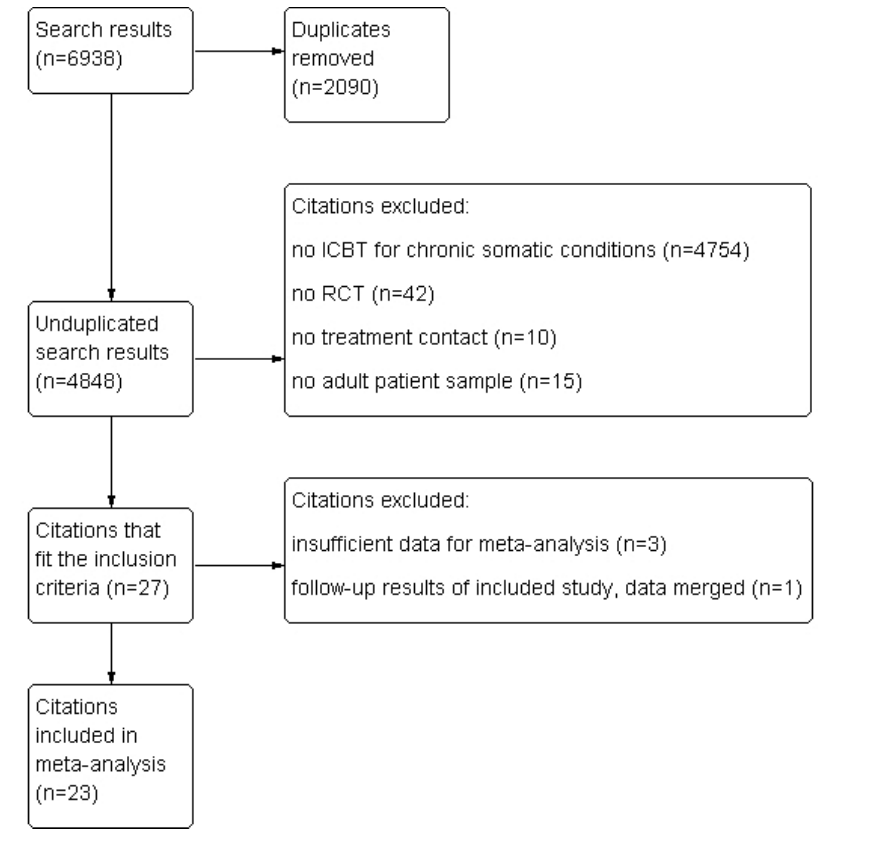
Figure 1. PRISMA flow diagram of study